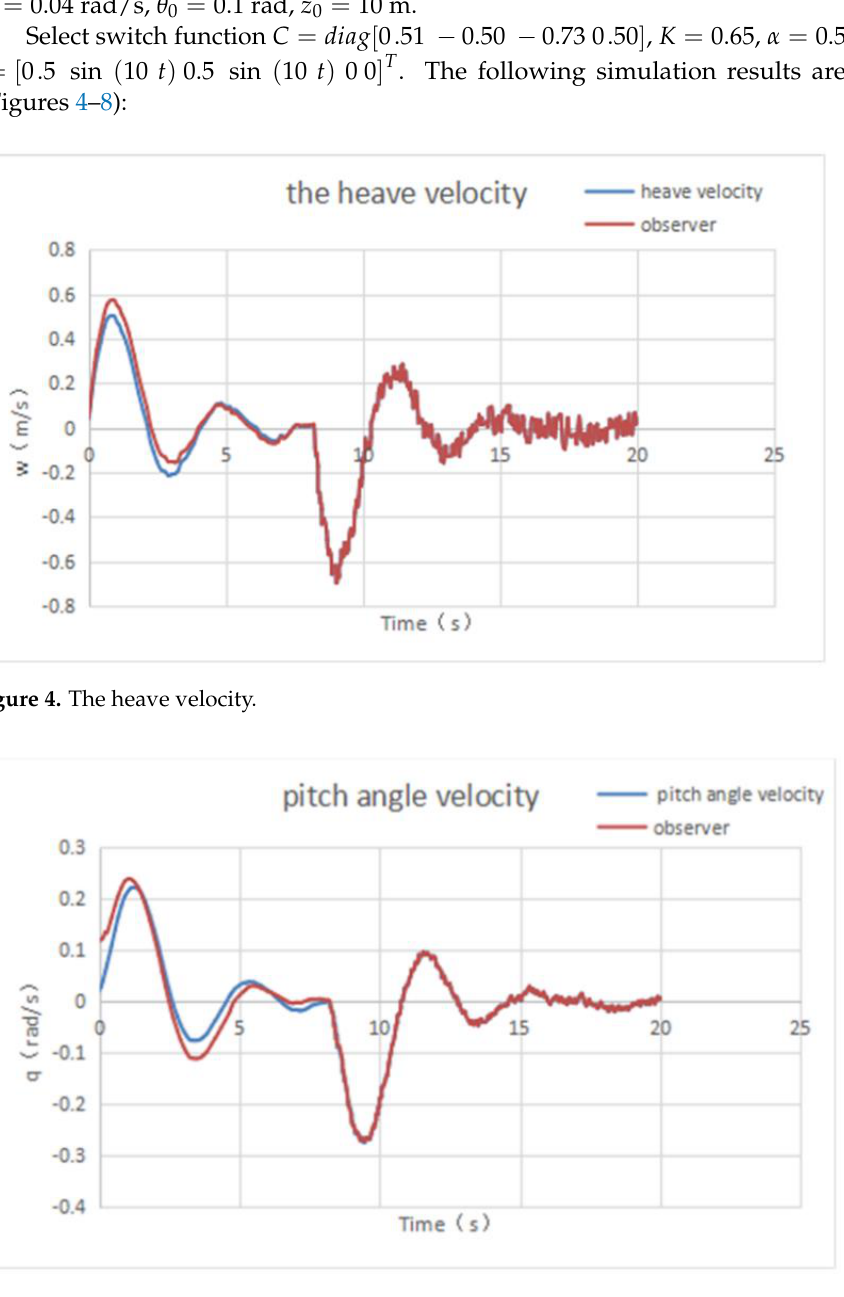
Figure 5. Pitch angle velocity.